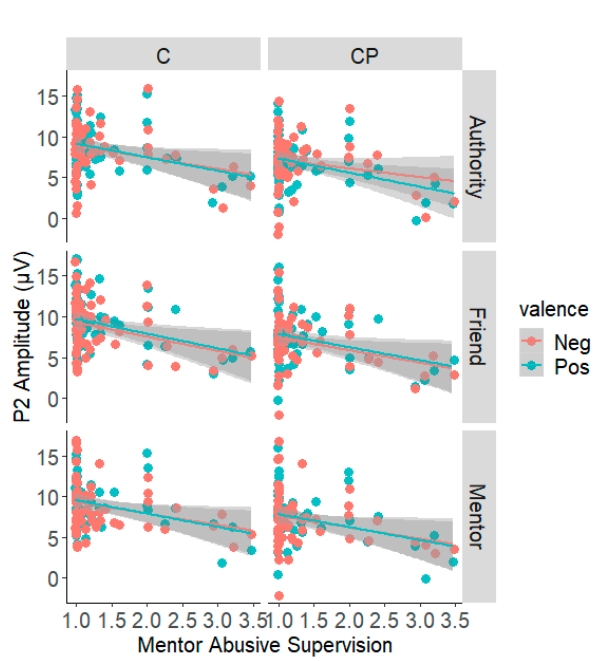
Figure 5. Association between abusive supervision and P2 amplitude.